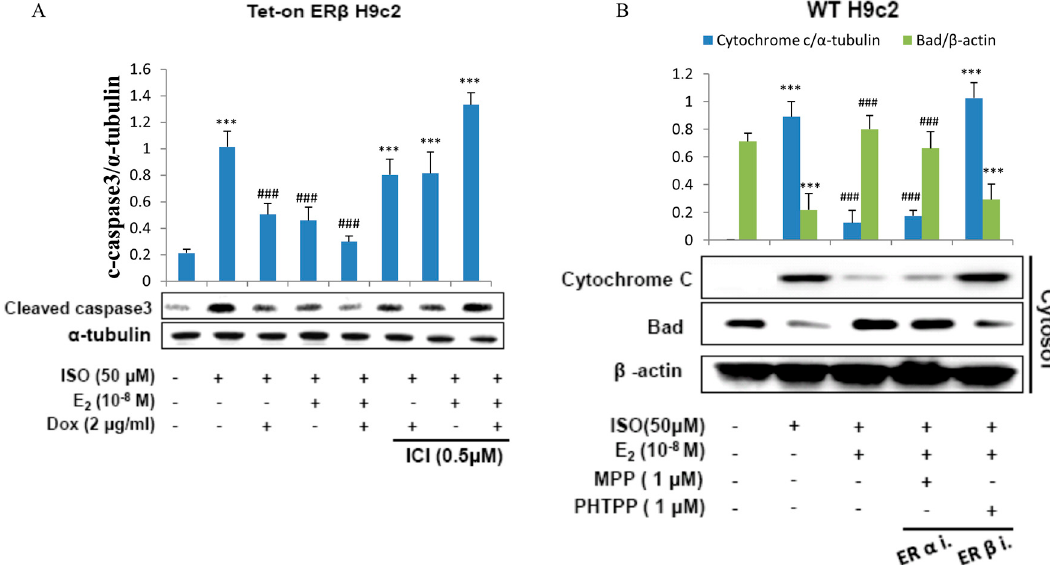
Figure 2. E2/ER β inhibits ISO-induced mitochondria-dependent apoptosis in H9c2 myocardial cells. ( A ), Tet-on ER β H9c2 cells were incubated with E2 (10 − 8 M), Dox (2 μ g/mL), ICI (0.5 μ M) in the presence of ISO (50 μ M) for 24 h, then western blotting was performed. Cleaved caspase3 and α -tubulin were detected by Western blot. ( B ), H9c2 cells were incubated with E2 (10 − 8 M), MPP (1 μ M), PHTPP (1 μ M) in the presence of ISO (50 μ M) for 24 h, then mitochondria isolation assay was performed. Cytochrome c and β -actin were detected by western blot. (*** = p < 0.001indicates significant difference with respect to the Control group; ### = p < 0.001 indicates significant difference with respect to the ISO challenged group).